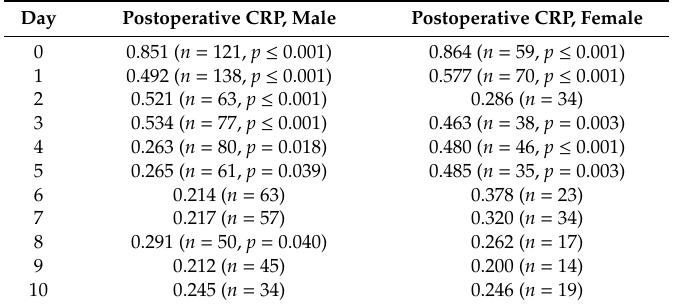
Table 3. Gender-specific subgroup analysis (male, n = 143; female, n =